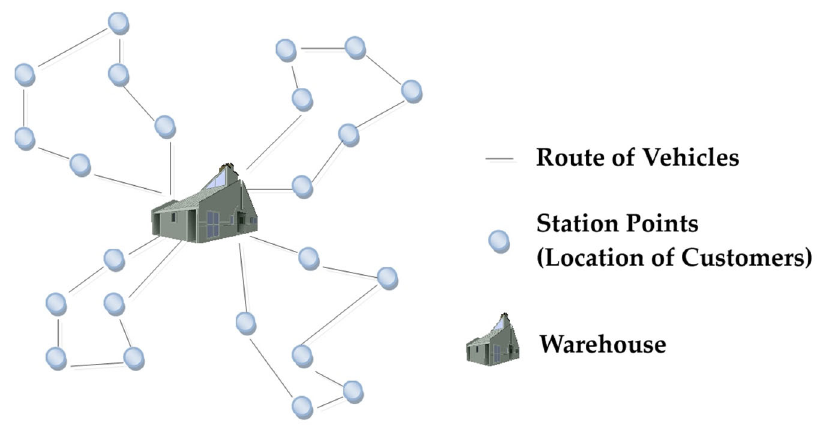
Figure 3. A simple illustration of the VRP routing network.